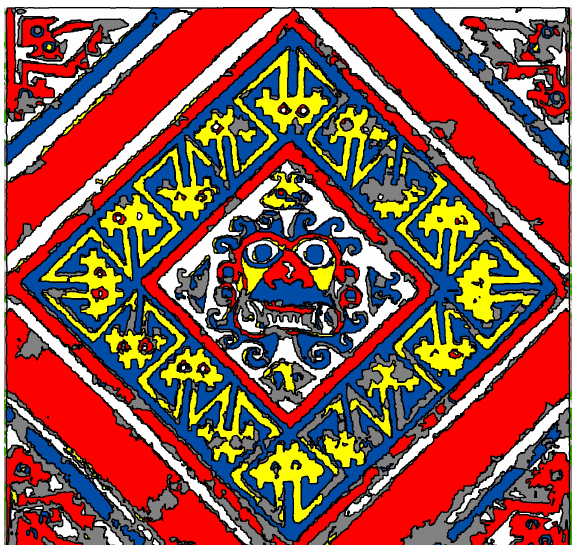
Figure 5. Object thematic map coming from the selection of per pixel classification into the segmented regions results of the pixel based comparison between 2006 and 2012 underlines the mayor changes in percentage for each